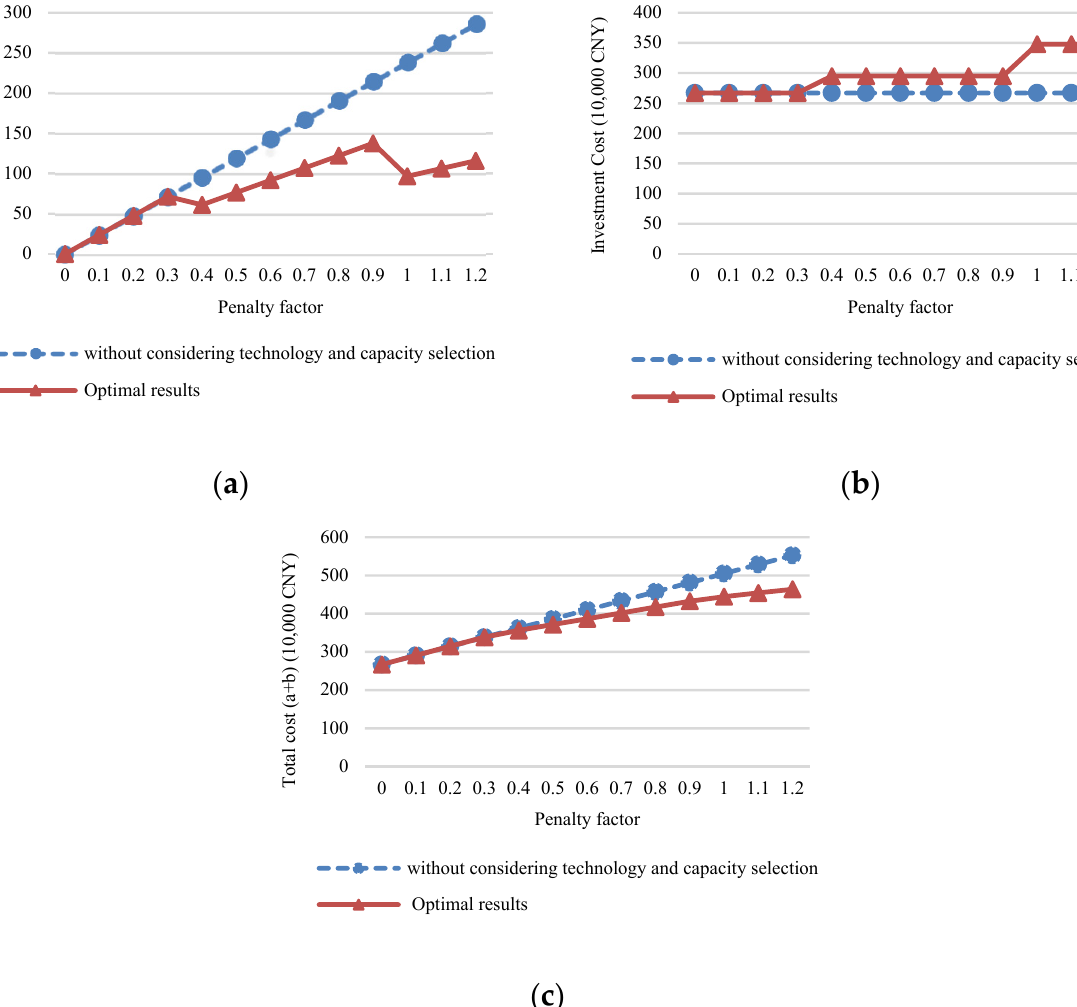
Figure 4. Cost comparison of desalination unit cost before and after optimization: ( a ) operating penalty cost; ( b ) investment cost; ( c ) total cost of operating penalty and investment.